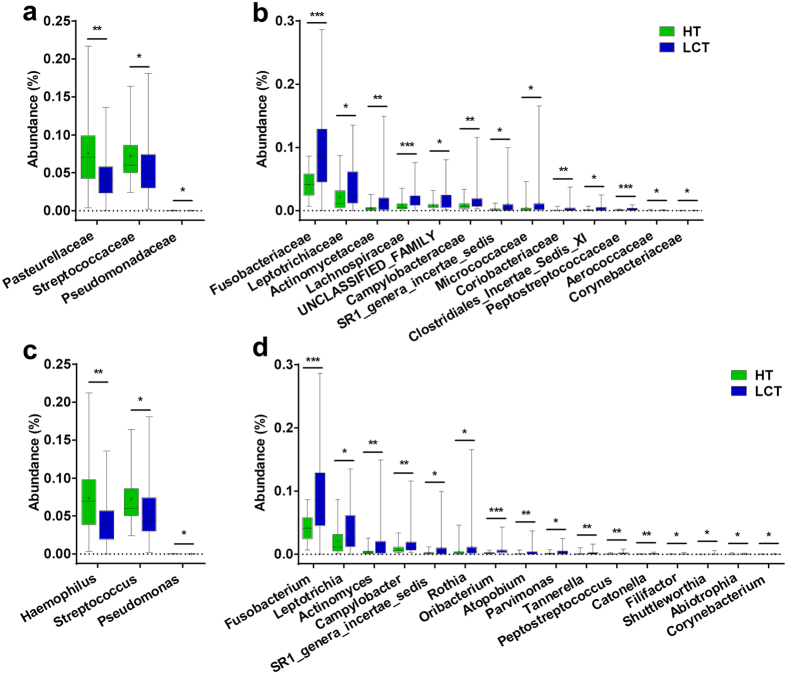
Comparison of the microbiome at the family (a,b) and genus (c,d) levels between LCT (blue) and HT (green), respectively. (a,c) Those enriched in HT; (b,d) those enriched in LCT; Box parameters, the “+” symbol represents median value, and the upper and lower ranges of the box represent the 75% and 25% quartiles, respectively; p values were calculated using the nonparametric Mann–Whitney test and are shown in Supplementary Datasets S2_b (Family) and_c (Genus); significant correlations by *p < 0.05; **p < 0.01 and ***p < 0.001. LCT, liver cancer patients tongue coat; HT, healthy subjects tongue coat.